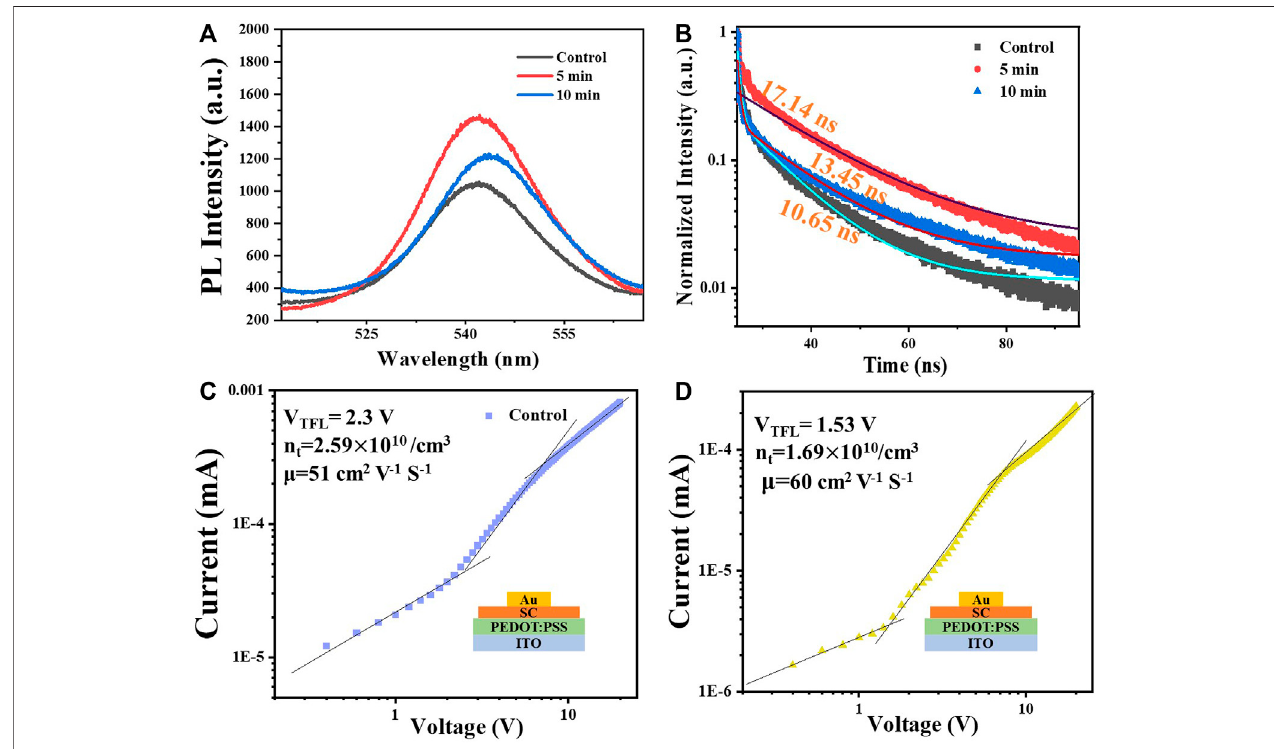
FIGURE 4 | (A) Photoluminescence spectra and (B) time-resolved photoluminescence of the control sample and sample after O 3 – UV exposure for 5 and 10 min. (C) – (D) Space chargelimited current(SCLC) measurement forthecontroland5 min O 3 – UV-treatedsample,andthestructuresofhole-onlydevicesaredisplayed inset.